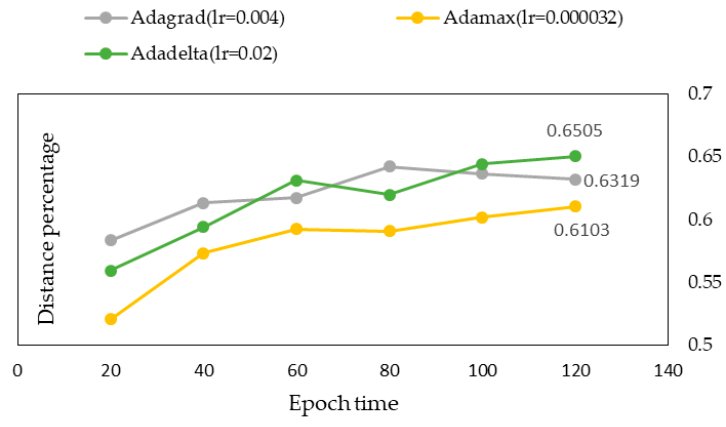
Figure 14. The distance percentage of different epoch times.